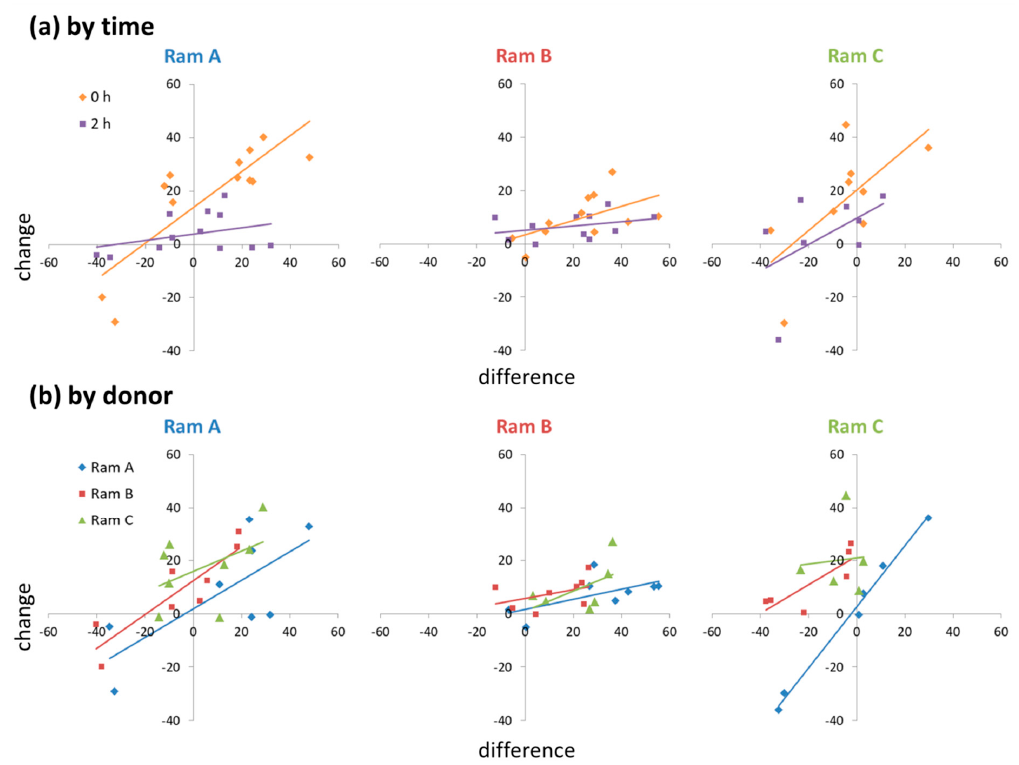
Figure 2. Ejaculate level effects of seminal plasma supplementation on changes in sperm motility: ( a ) RamxTimexDifference interactions; ( b ) RamxDonorxDifference interactions.